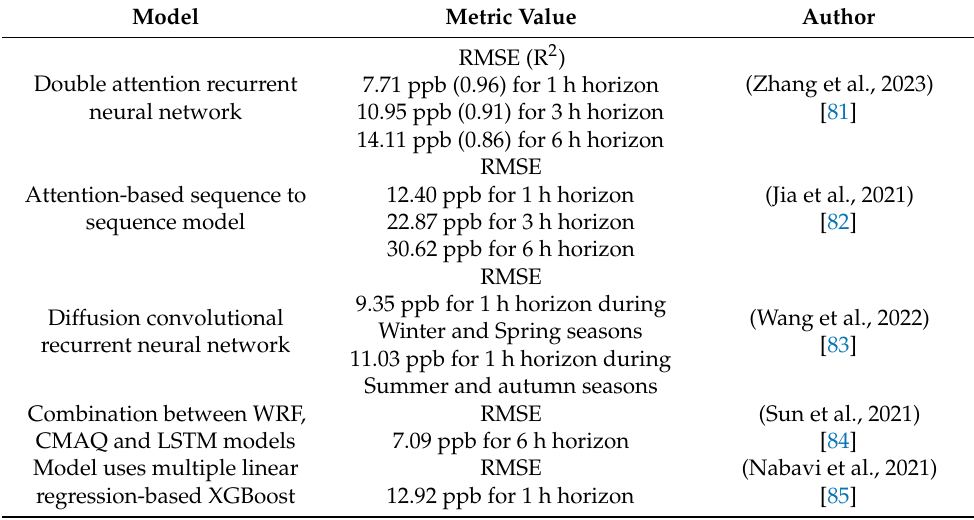
Table 2. Literature values for ozone